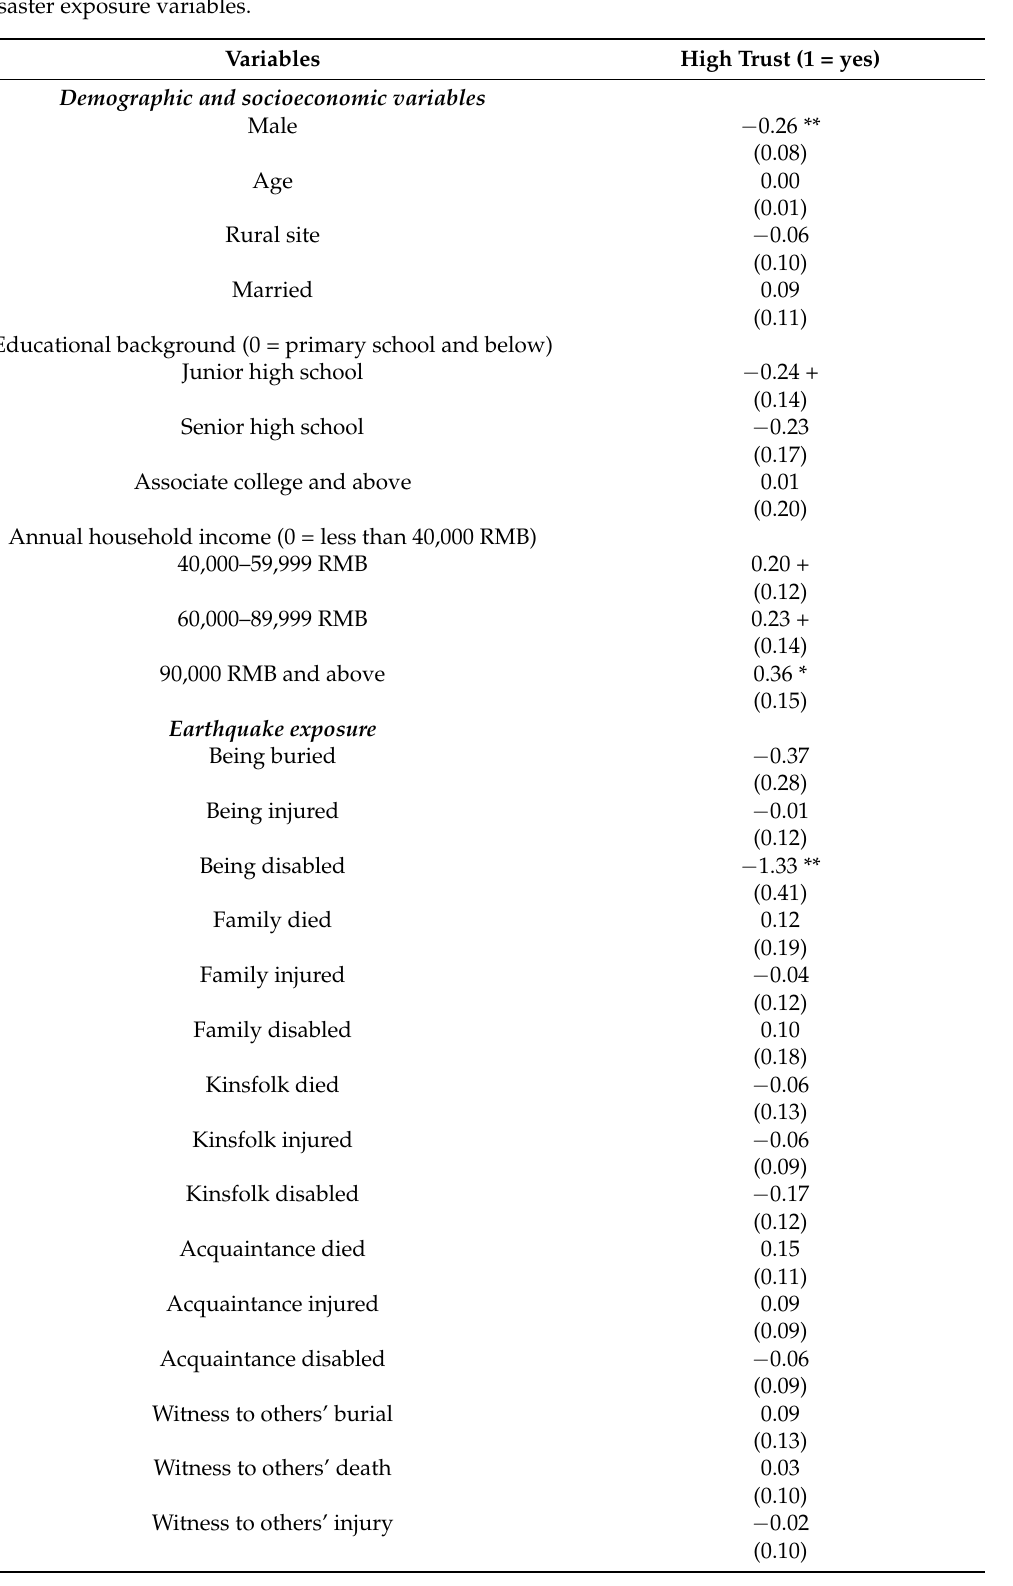
Table A2. Probit model of predicting high trust by demographic and socioeconomic variables and disaster exposure